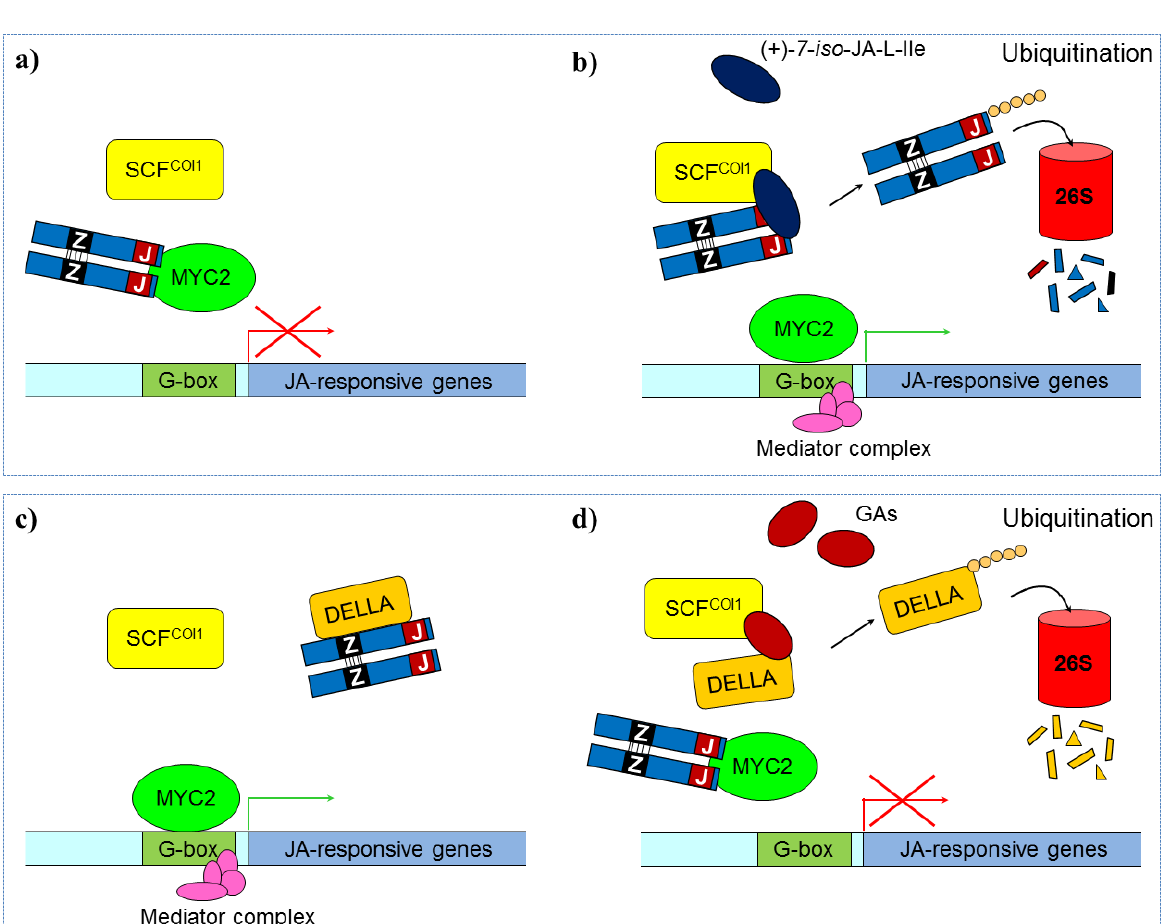
Figure 6. Model of jasmonate regulation of defense responsive genes. ( a ) In the resting state, in the absence of JA, JAZ proteins will bind to transcription factors, such as MYC2, and prevent expression of the JA-responsive genes; ( b ) In the active state, wounding promotes JA biosynthesis, resulting in accumulation of (+)-7- epi -jasmonyl- L -isoleucine ((+)-7- epi -JA- L -Ile). The hormone will bind to and stabilize the COI1 F-box subunit of the COI1 E3 ubiquitin ligase enzymatic complex (SCF COI1 ), which in its turn bind to the Jas motif (J) of the Jasmonate ZIM-domain protein (JAZ), leading to ubiquitination and subsequent degradation by the 26S proteasome (26S). The transcription factors will now be free to recruit the RNA polymerase II transcriptional machinery to the promoter of the JA-responsive genes, assisted by universal adaptors, such as the Mediator complex; ( c ) In the presence of (+)-7- epi -JA- L -Ile and the absence of gibberellic acids (GAs), stabilized DELLA proteins (DELLA) will compete with MYC2 for binding of JAZ, thereby releasing MYC2 for activation of the JA-response; ( d ) If GAs are present, they will bind to DELLA and trigger degradation. This will liberate JAZ, promote the formation of the JAZ-MYC complex, and thereby repress the expression of JA-responsive gene (Adapted from